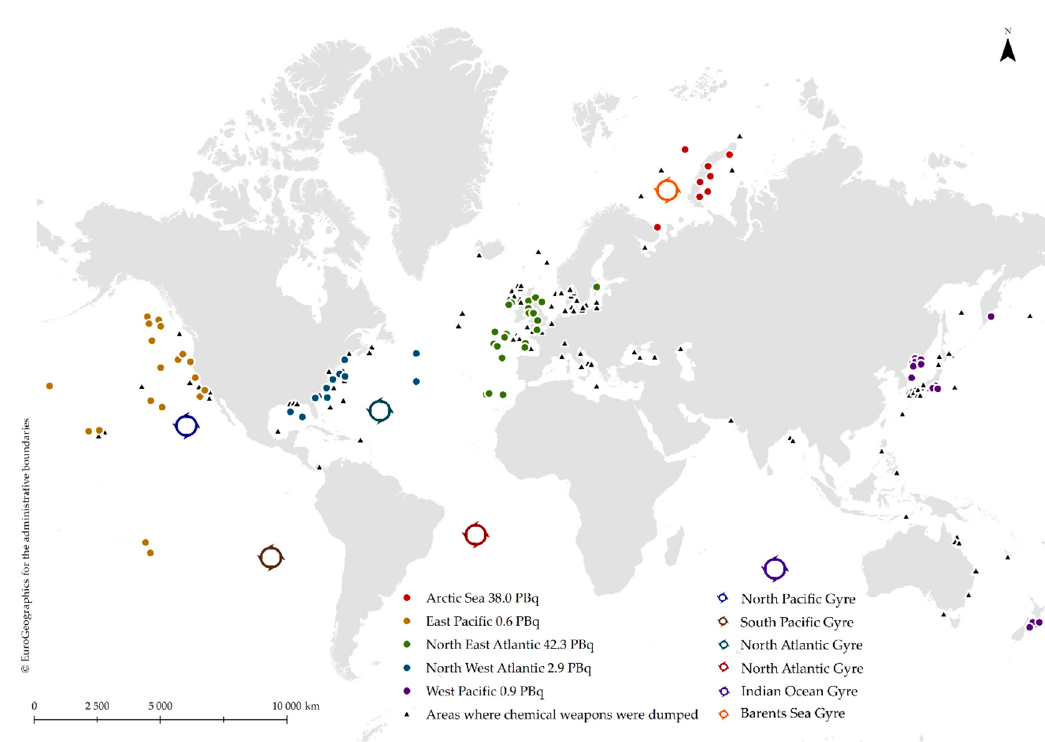
Figure 1. The location of ocean garbage patches, the global inventory of radioactive waste disposal at sea (total amounts in petabequerels per region) and chemical weapons dumped at sea. Data sources: [7,40–42], administrative boundaries in shapefile format were obtained from Eurostat’s geodata database [43].